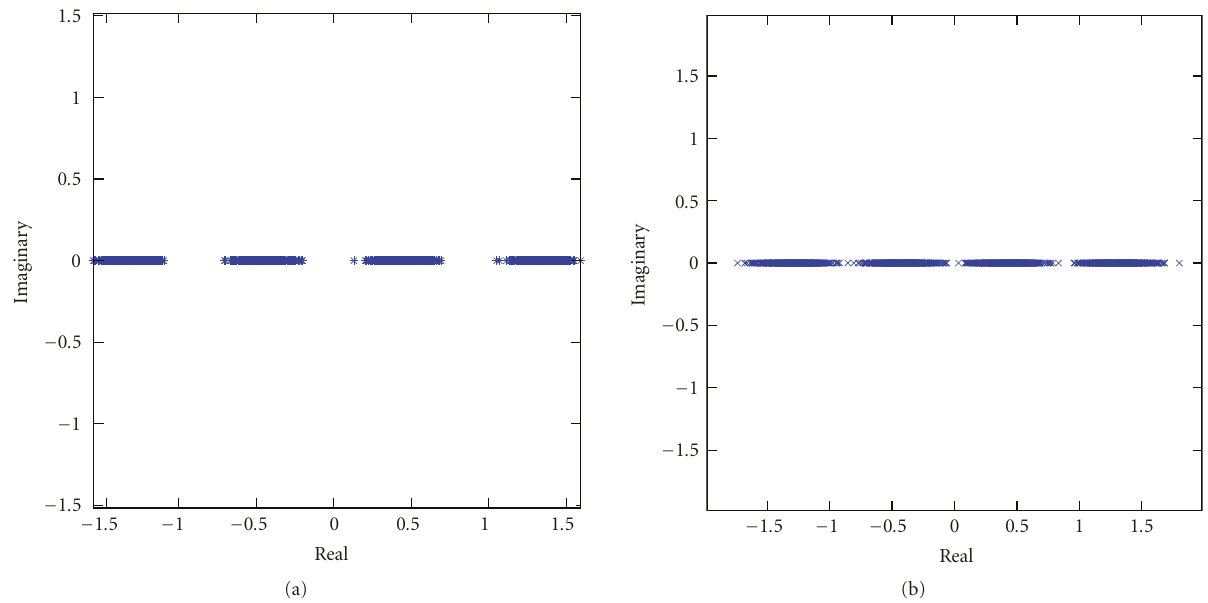
Figure 8: 4-PAM constellations after equalization using (a) GPS or (b) CMA2.